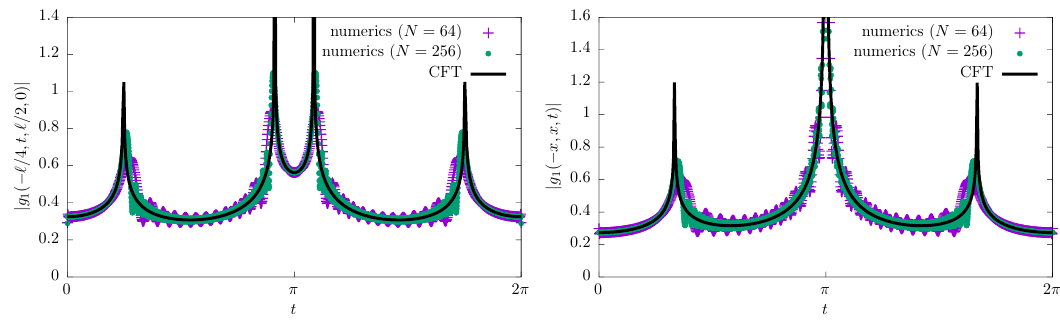
( − (cid:96)/ 4, t , (cid:96)/ 2,0 ) | as a function of time. Here 1 ( − (cid:96)/ 2, t , (cid:96)/ 2,0 ) | . 1